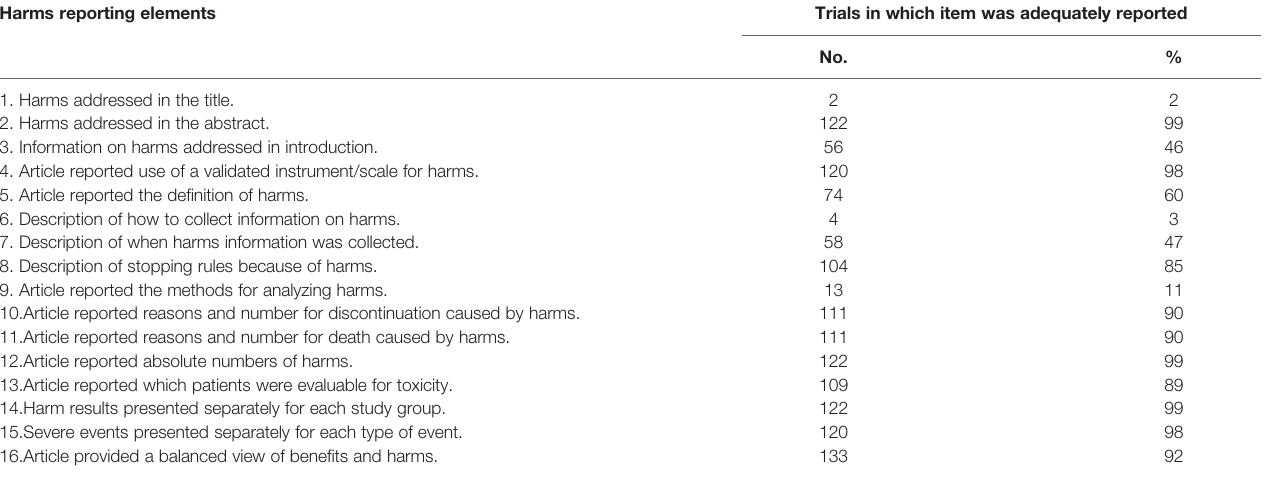
TABLE 3 | Quality of harms reporting using each 16 adverse event reporting